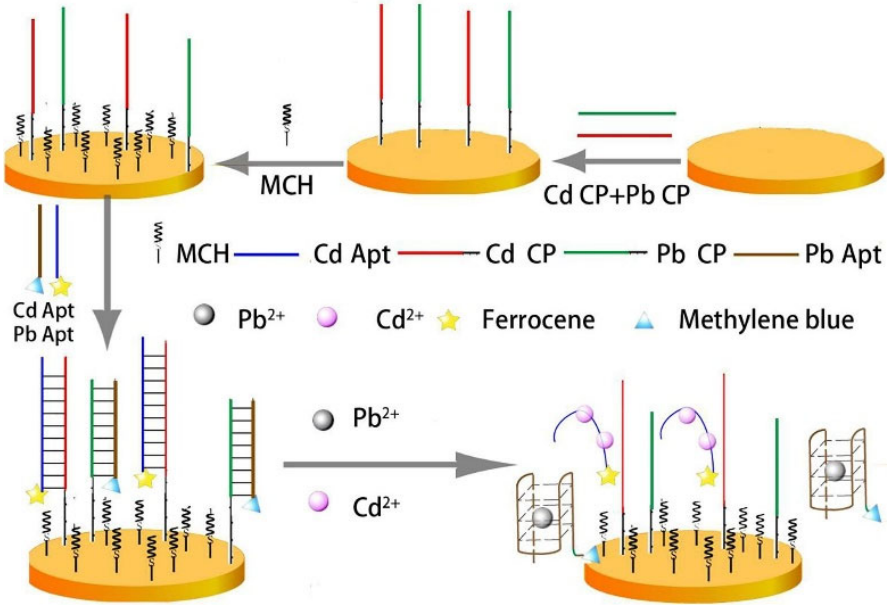
Figure 14. Schematic diagram of electrochemical aptamer sensor for Cd 2+ and Pb 2+ detection (Reprinted with permission from Ref. [57]. 2022, Yuan et al.).